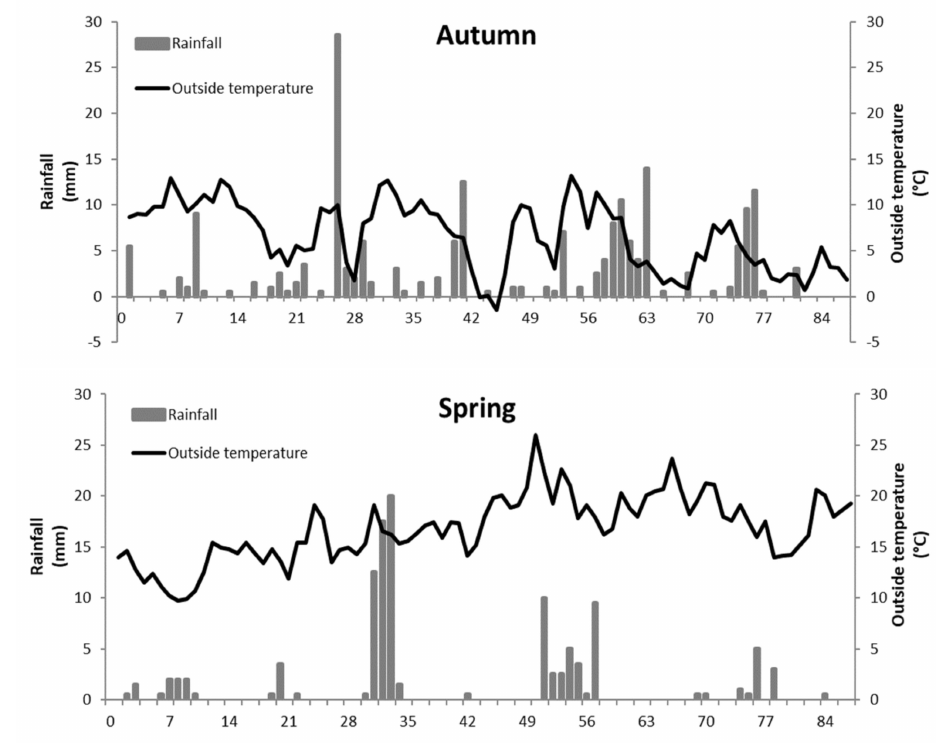
Figure 4. Rainfall and outside temperature over the 85 days of storage in autumn and spring.